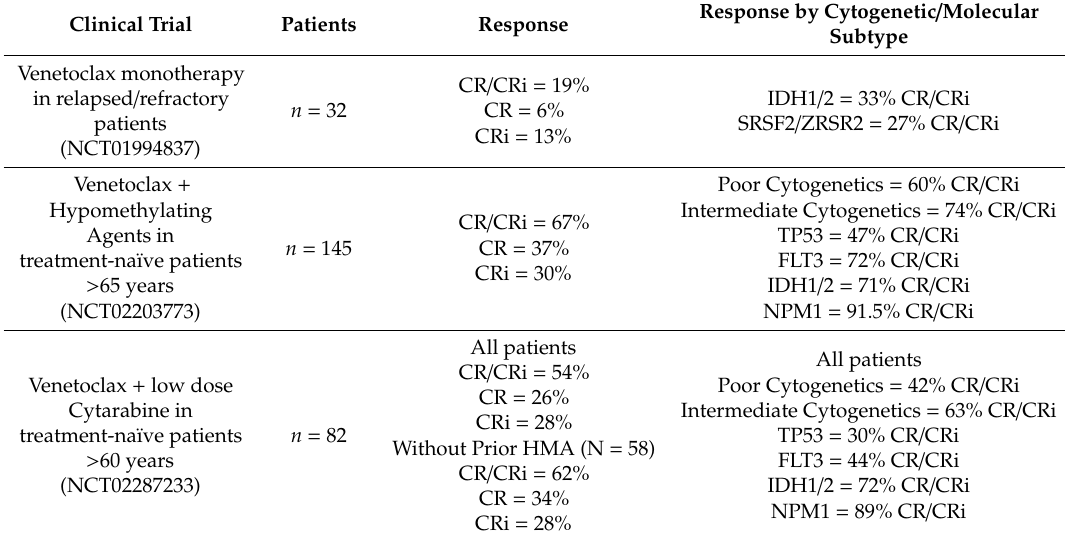
Table 2. Venetoclax Responses in Acute Myeloid